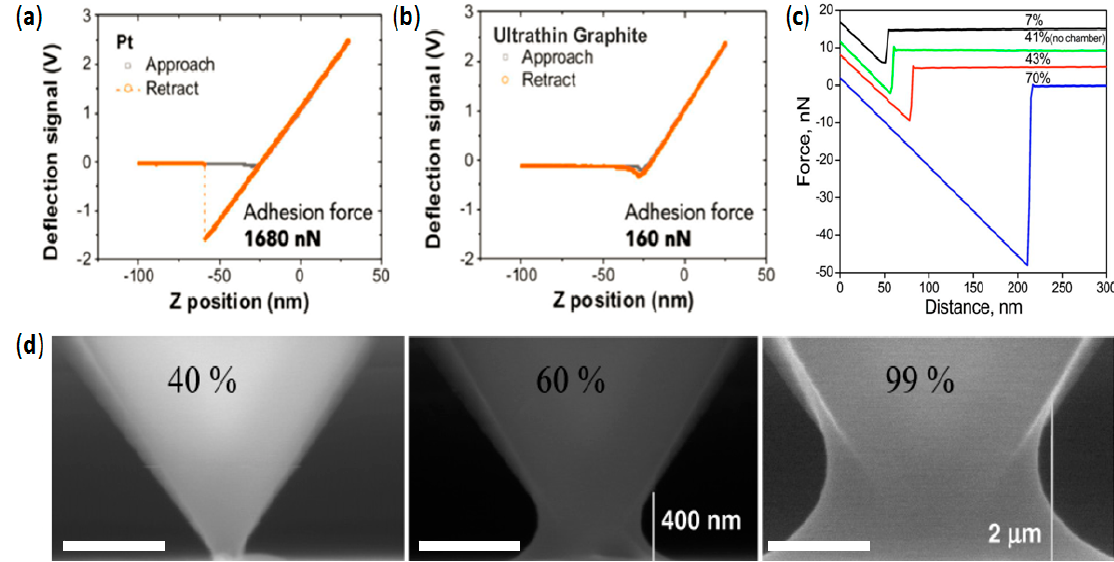
Figure 9. Tip-sample interaction. Force-distance curves collected on Silicon substrate with a Pt coated AFM tip ( a ) and ultrathin graphite coated tip ( b ). Reproduced with permission from [27], copyright Springer Nature Publishing Group (2016); ( c ) Representative force-distance curves obtained by retracting a Si cantilever from a freshly-cleaved mica surface at different RH values that are listed next to each curve. Reproduced with permission from [43], copyright American Institute of Physics (2006); ( d ) Sequence of images collected at various relative humidity. The scale bars are 1 μ m. Reproduced with permission from [42], copyright American Chemical Society (2005).